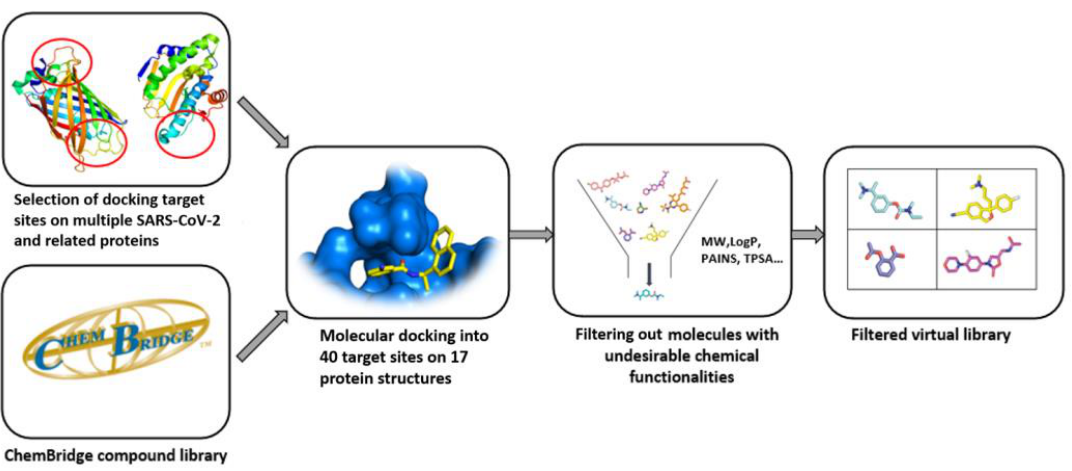
Figure 5. Process algorithm for generating the ChemBridge SARS-CoV-2-targeted molecular library.